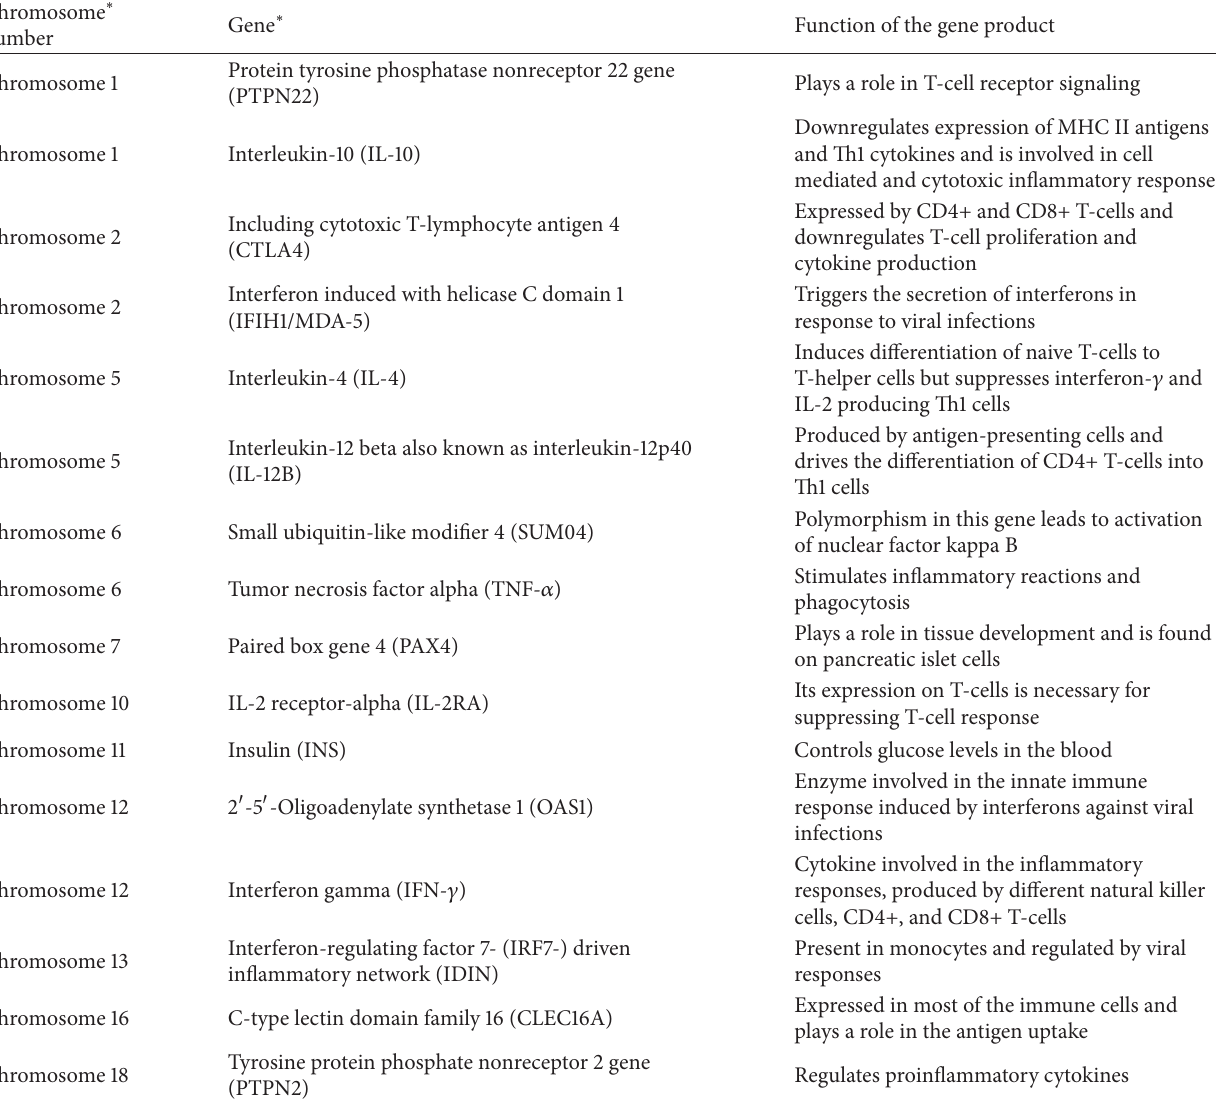
Table 3: Nonmajor histocompatibility complex genes and gene products associated with type 1 diabetes by genome wide association